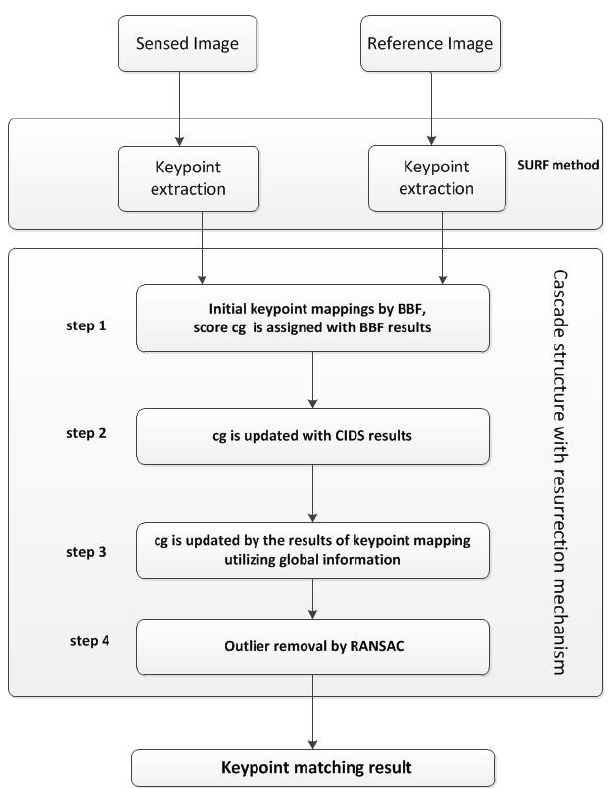
Figure 2. The proposed cascade structure with the resurrection